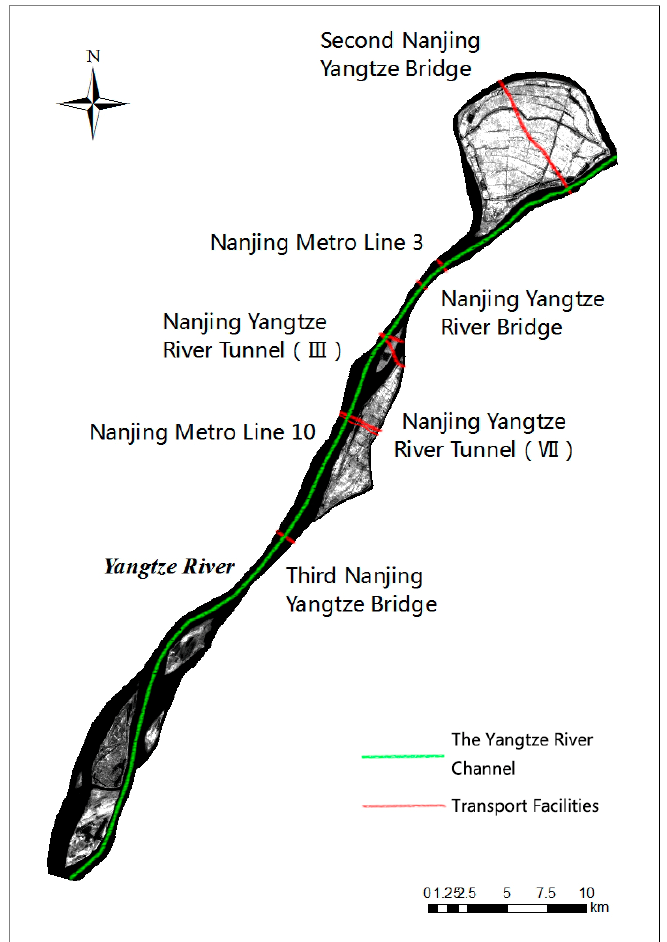
Figure 12. Map of the channel in NYR by band 4, Landsat 7 ETM+ acquired on 10 October 2000.